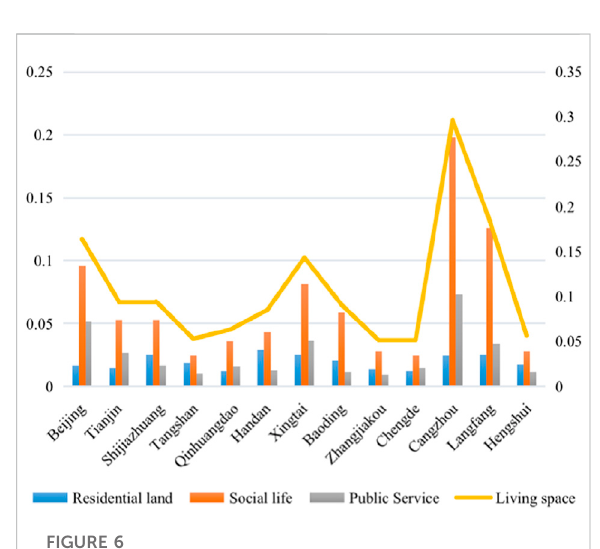
space in Beijing-Tianjin-Hebei.